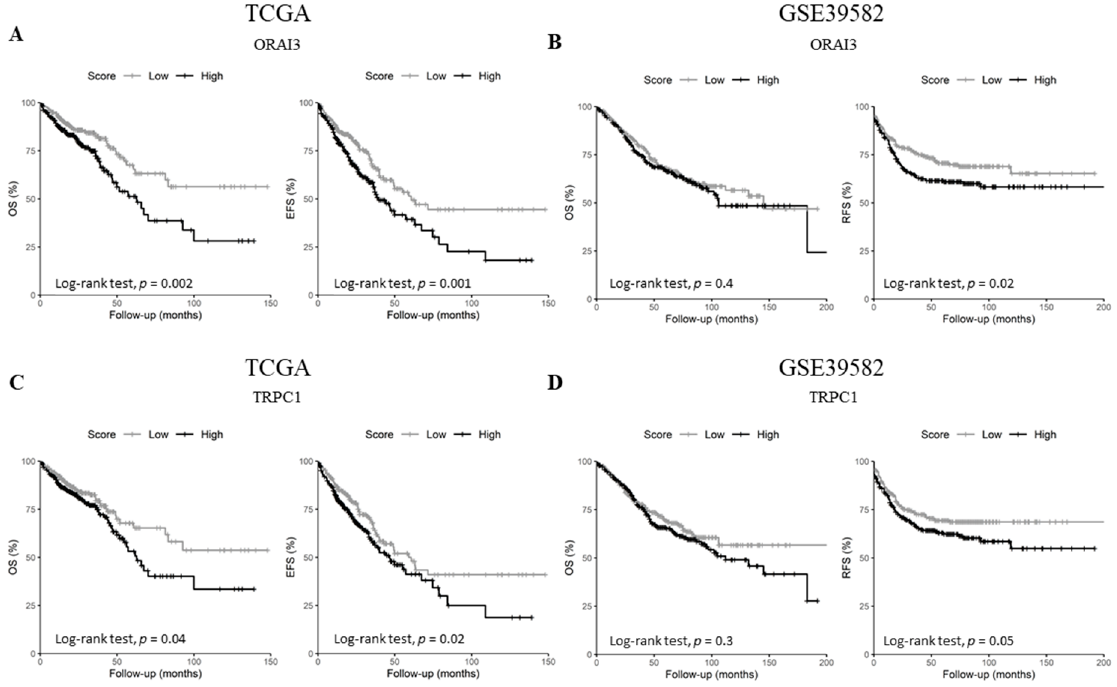
Figure 5. Kaplan-Meier survival curves of ORAI3 and TRPC1 genes in TCGA and GSE39582. ( A ) OS and EFS survival curves for ORAI3 in the TCGA dataset; ( B ) OS and RFS survival curves for ORAI3 in the GSE39582 dataset; ( C ) OS and EFS survival curves for TRPC1 in the TCGA dataset; ( D ) OS and RFS survival curves for ORAI3 in the GSE39582 dataset. High and Low scores were attributed to patients using gene-median expression as a threshold. Comparison between High and Low categories was done using a Log-Rank test. Abbreviations: OS: Overall survival. EFS: Event-free survival. RFS: Relapse-free survival.